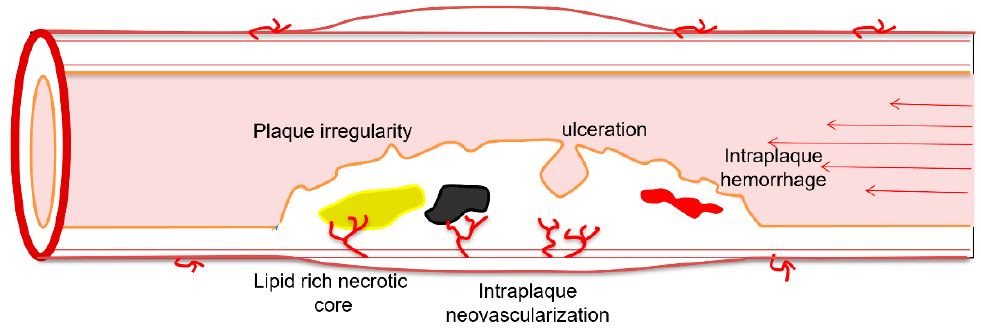
Figure 1. Schematic drawing showing the vulnerability features of carotid plaque: intraplaque hemorrhage appears as a red area; lipid rich necrotic core appears as a yellow area; plaque surface irregularity and ulceration appears as a line covering the plaque; intraplaque neovascularization appears as thin red branching vessels inside the plaque. Calcification with acoustic shadowing is also included but is a protective feature of carotid atherosclerosis.